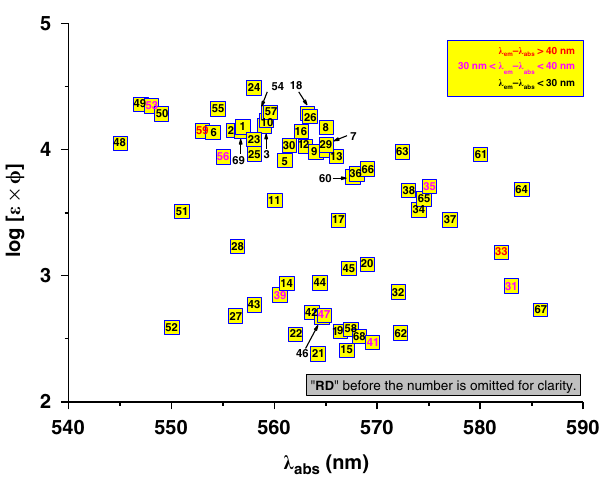
Fig. 2 Fluorescence properties of the rhodamine library in PBS buffer. The y- axis is the brightness, which is expressed as log ( ε × Φ ) of a given rhodamine dye and the x -axis is the absorption maximum. RD23 and RD24 were tested in (Supplementary Figure 70) and RD28 may scavenge 1 O 2 and produce a fl uorescence turn-on of ca. 14 fold (Supplementary Figure 71).